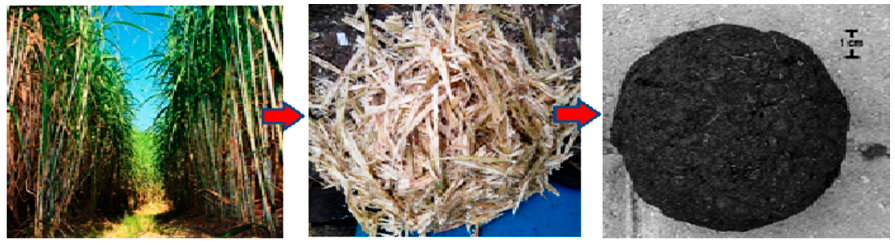
Figure 3. Processes to produce sugarcane bagasse ash [34].